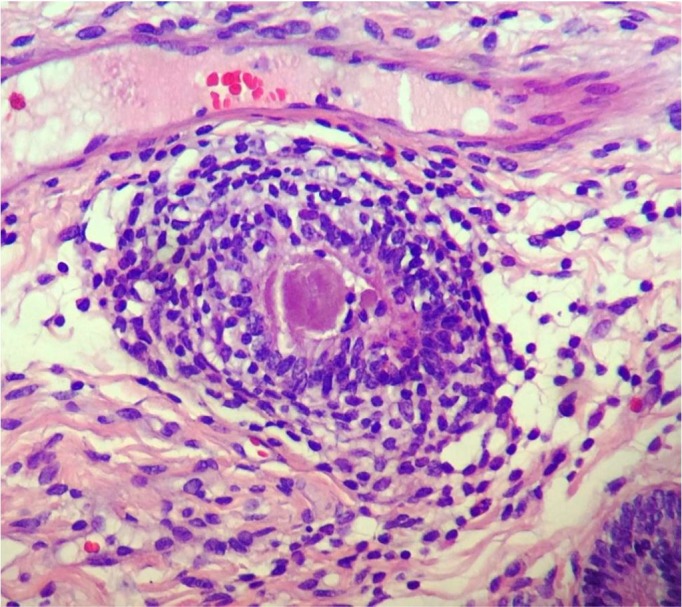
Gynecological examination in Pantaneiro mares. Endometrial biopsy in mare 7 shows lymphocyte infiltration around the gland. Hematoxylin-eosin staining, 40×.